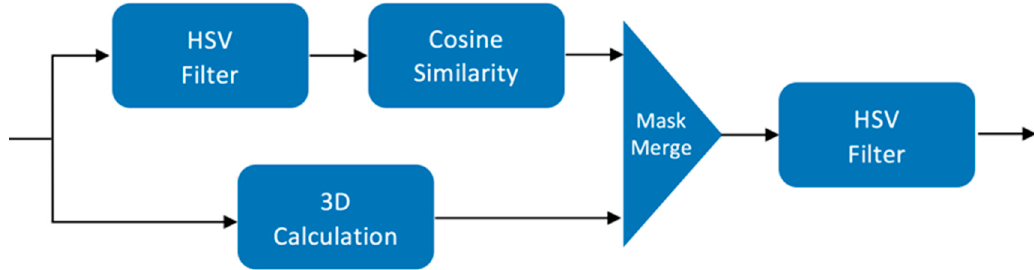
Figure 10. Once the frame is extracted from the scan, it is fed through our image processing algorithm to isolate the specific food item with the laser dots visible on that